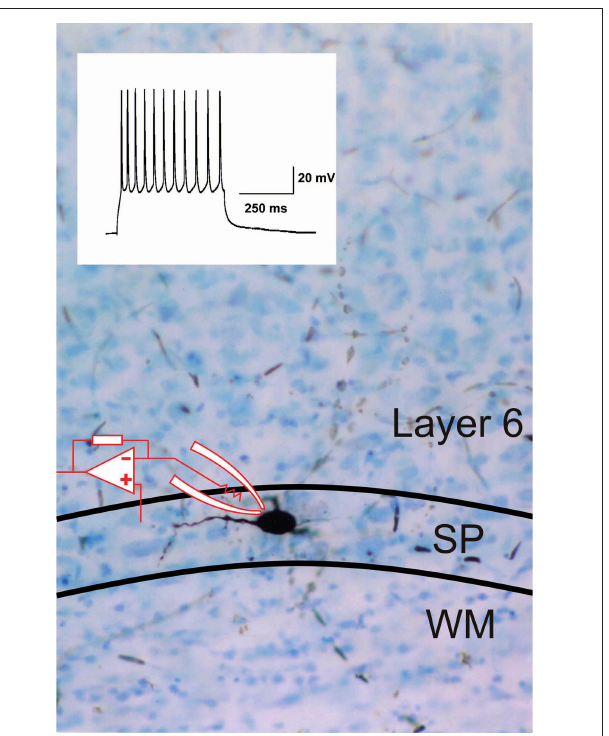
FIGURE 2 | Photomicrograph of biocytin fi lled subplate neuron in the subplate (SP) area at the bottom of layer 6, also from rat visual cortex acute brain slice preparation. Some of the cell’s dendrites can be seen extending into layer 6. The inset shows an electrophysiological response of the cell recorded under current clamp with whole cell patch recording in response to a sustained depolarization, producing a non-decrementing train of action